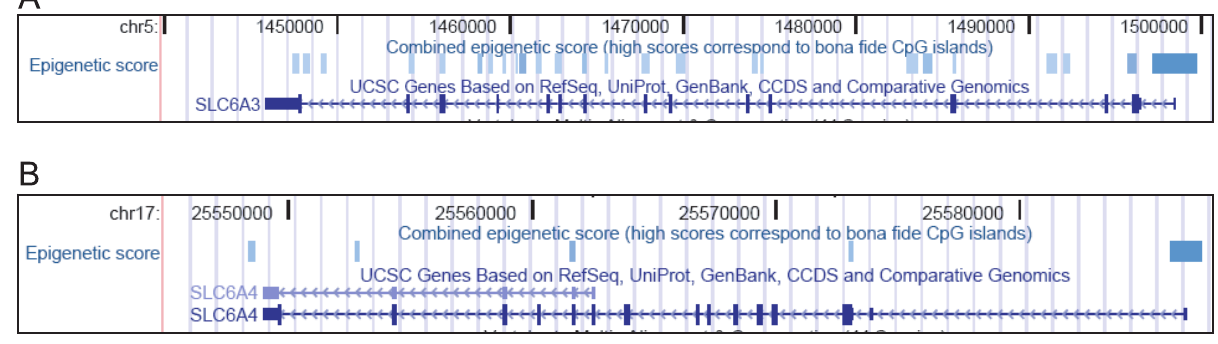
Figure 6. Bonafide CGIs in the SLC6A3 and the SLC6A4 regions. Visual displays of the bona fide CGIs (CpG islands) are obtained using Custom Tracks option (UCSC Genome Browser). Here, blue boxes represent predicted CGIs based on combined epigenetic score. Note, that in the SLC6A3 locus (top panel), multiple GCIs are distributed within all gene regions whereas in the SLC6A4 locus (lower panel), CGIs are evidently less numerous.